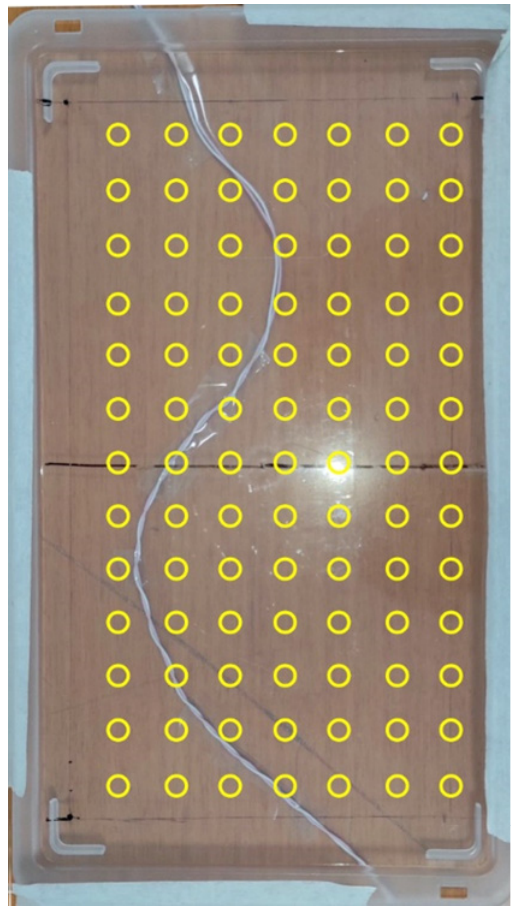
Figure 4. Measurement setup for the test on the copper wire. The yellow circles correspond to the measurement points.